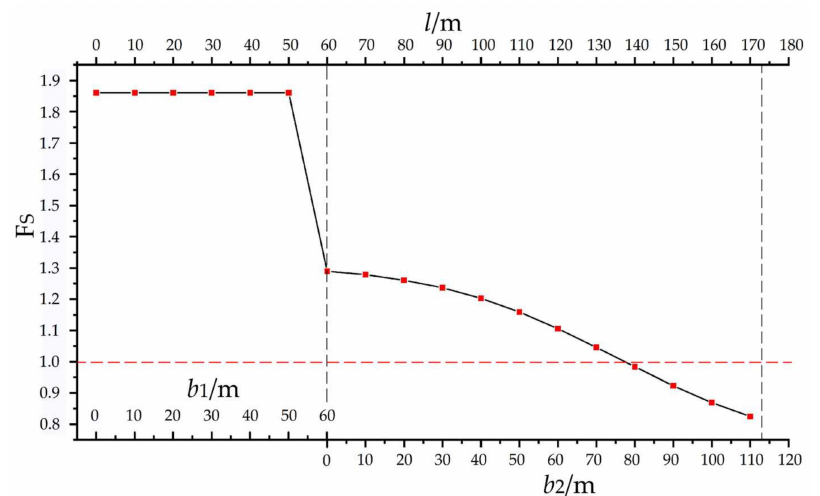
Figure 15. Relationship curve between the characteristic values of the Danbo deformation body at different stages and slope stability